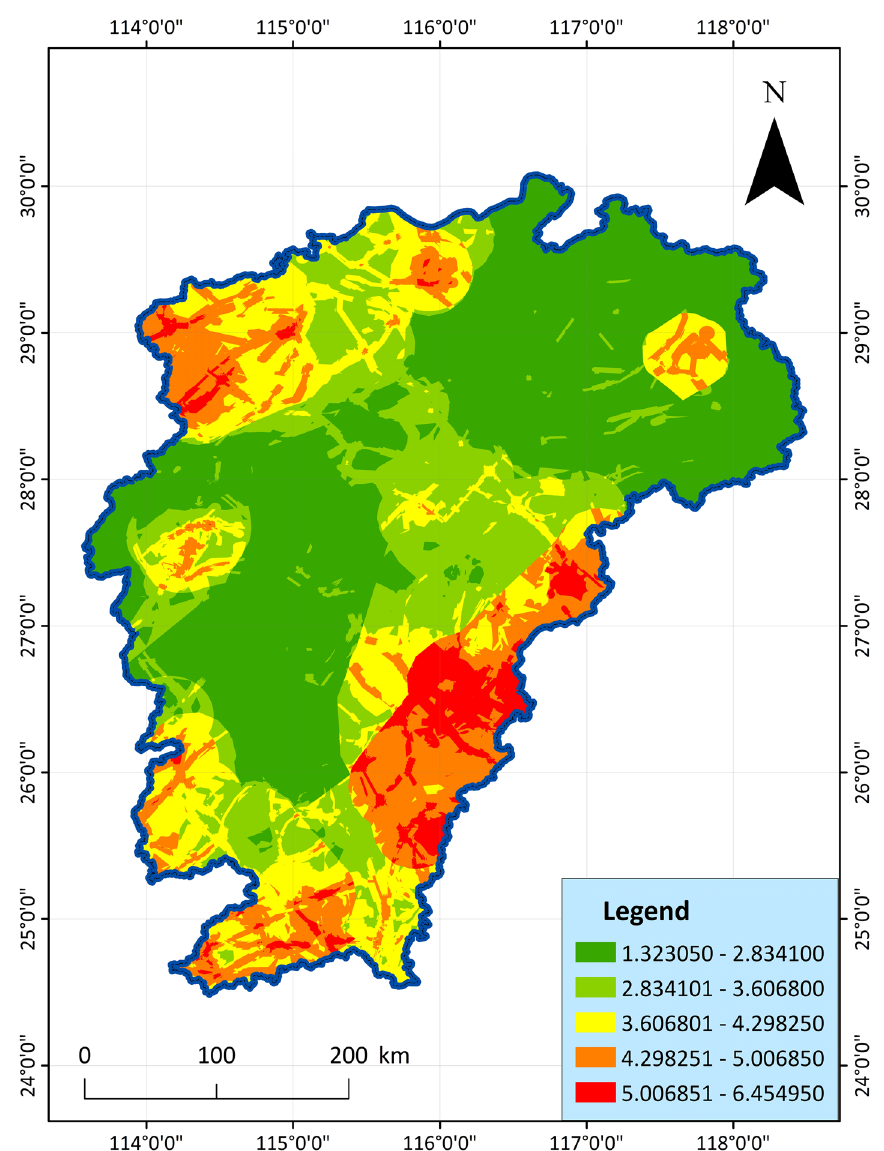
Figure 14. AHP geothermal resource potential evaluation diagram, showing the potential score for each